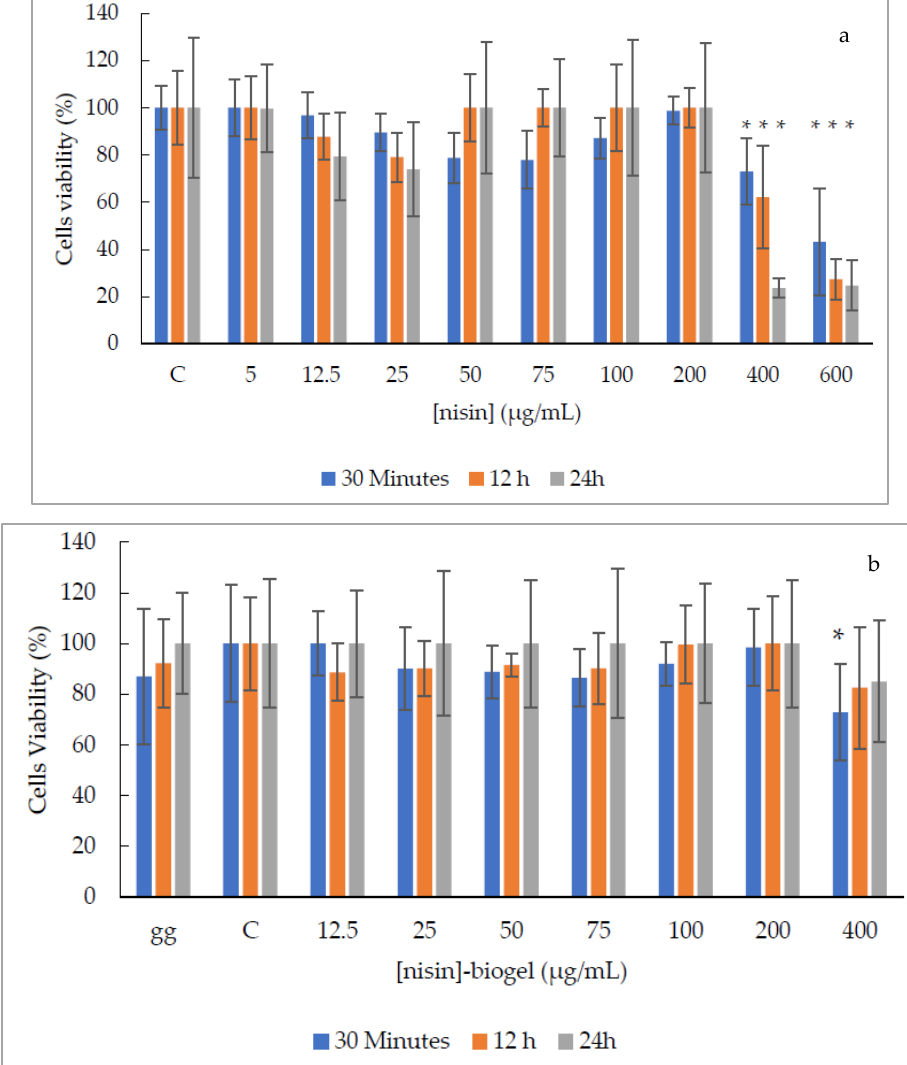
Figure 2. Vero cell line viability (%), after three treatment periods (30 min, 12 h and 24 h) with nisin and nisin-biogel solutions. a —Distribution of cells viability (%) after exposure to nisin at concentrations ranging between 5 to 600 µg/mL, after three treatment periods. b —Distribution of cells viability (%) after exposure to nisin-biogel at concentrations ranging between 12.5 to 400 µg/mL, after three treatment periods. C—negative control with no treatment. gg—control with non-supplemented biogel. The vertical bars represent standard deviations of means * p -value ≤ 0.05.